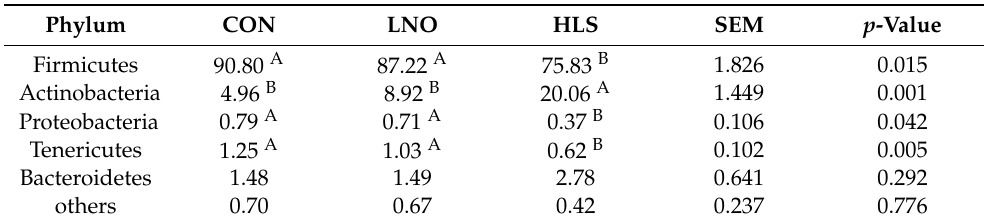
Table 8. The effect of dietary flaxseed oil or flaxseed supplementation on the relative abundance of bacteria in ileum digesta—Phylum level (%). Phylum CON LNO HLS SEM p